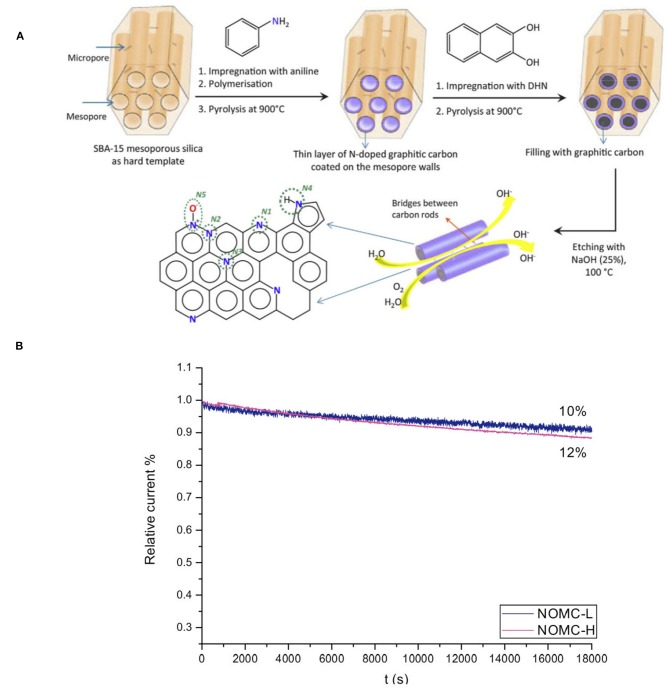
(A) Schematic illustration of the formation of a NOMC with a layer of N-doped carbon at the surface and a fully carbonaceous core, using SBA-15 as hard template. The possible configurations of N atoms in the NOMC material are indicated: pyridinic N (N1), graphitic N (N2-N3), pyrrolic N (N4), and oxidized pyridinic N (N5). (B) Relative current density vs. time (J-t) plot based on chronoamperometric measurements of NOMCs at −0.4 V vs. Ag/AgCl in O2-saturated 0.1 M KOH at a rotation speed of 1,600 rpm. From Sheng et al. (2015) with permission from ScienceDirect.